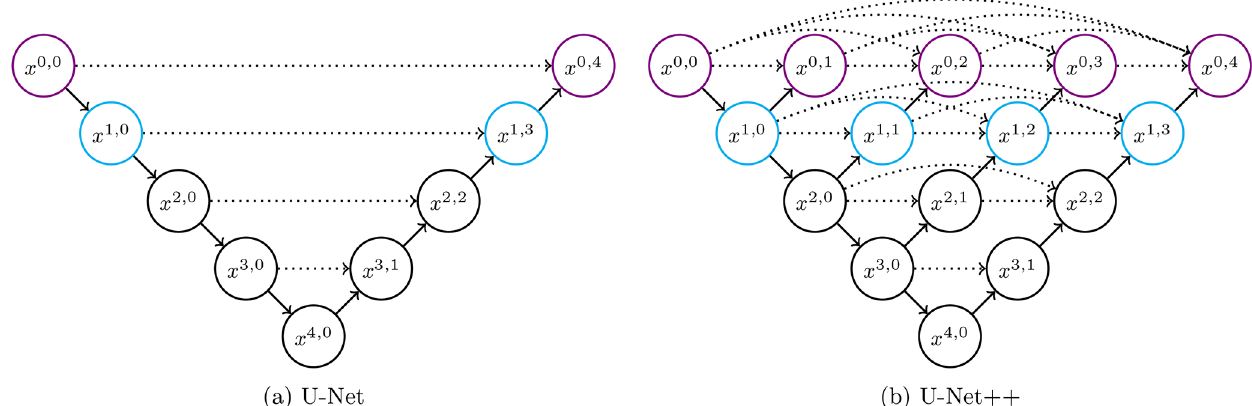
Figure 2. Skip connection-based models tested for the transfer functions. The three-layer version of each model is made up of only the black coloured nodes, the four-layer version of the black plus the cyan nodes, and the five-layer version of all of them. The (cid:38) represents down-sampling , the (cid:37) up-sampling , and the skip connections . The nodes x i,j represent the ConvBlocks